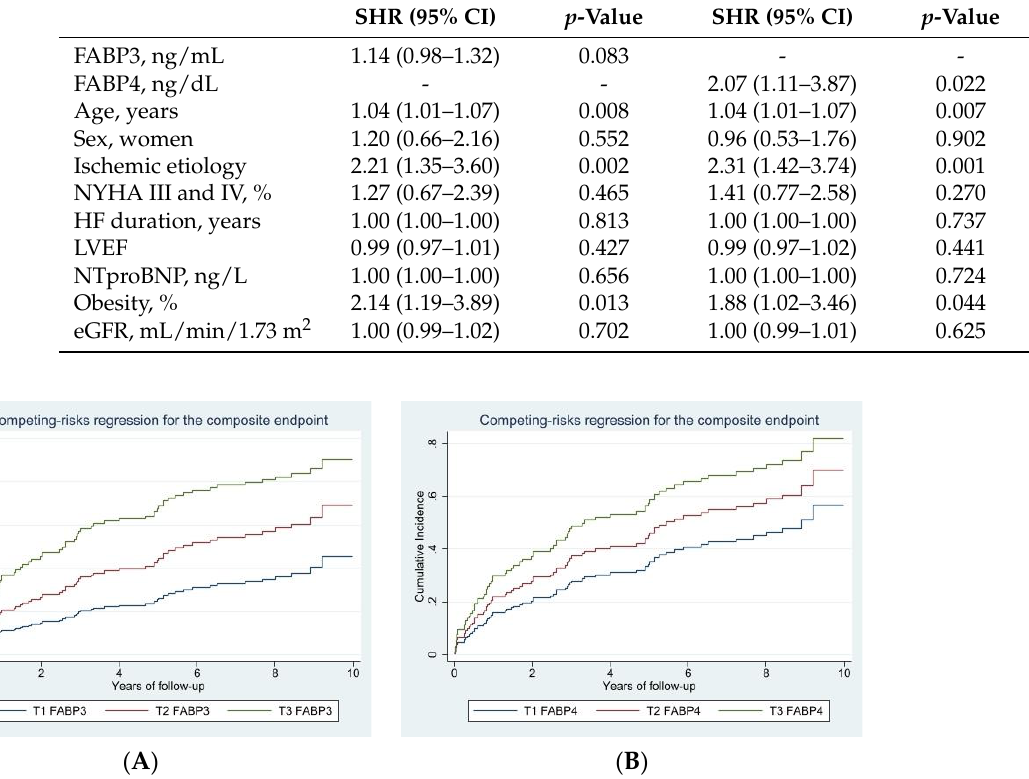
Figure 2. Composite endpoint (death or rehospitalization) stratified by the tertiles of serum FABP3 ( A ) and FABP4 ( B ) in T2D patients. Data adjusted by age, gender, ischemic etiology, NYHA III and IV, HF duration, LVEF, NTproBNP, obesity and eGFR are expressed as incidence of death or rehospitalization by competing-risks regression. Overall p -value < 0.01.